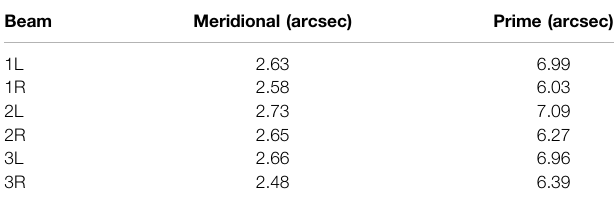
TABLE 6 | Statistical information of 2-min GVD directional component. Beam